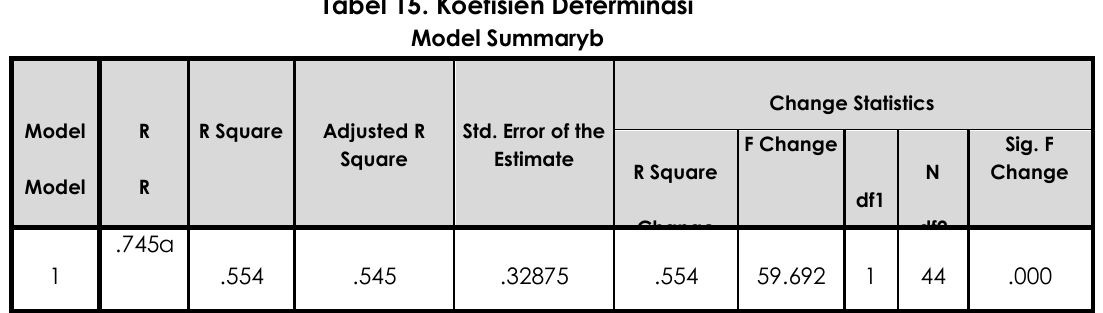
Tabel 15. Koefisien Determinasi Model